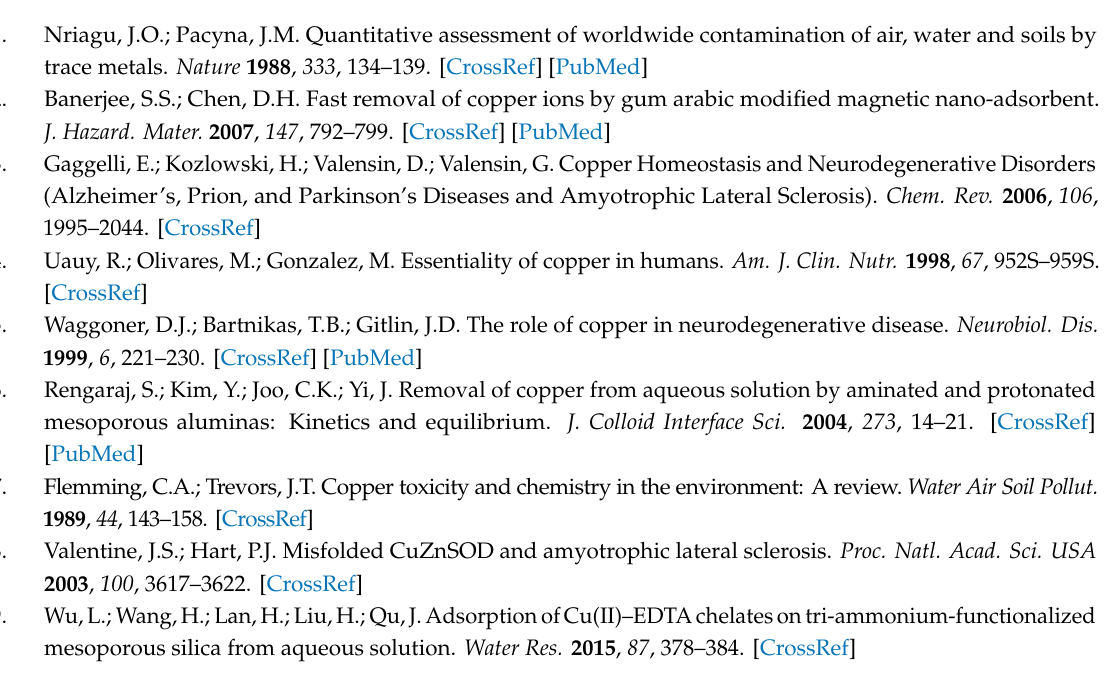
Figure S1. XRD pattern of the cobalt ferrite MNPs@ODA. Figure S2. FT-IR spectra of the pure surfactants. Figure S3. Ninhydrin colorimetric analysis of the primary MNPs@ODA with the three surface modified samples. Figure S4. UV–Vis titration of blank solution (Cu(NO 3 ) 2 ) with MNPs@ODA@PEI@DTPA. Figure S5. FT-IR spectra of the MNPs@ODA@PEI@DTPA and MNPs@ODA@DTPA before and after the adsorption of copper ions. Figure S6. FT-IR spectra of the regenerated MNPs@ODA@PEI. Figure S7. FT-IR spectra of the ligand DTPA and the copper complex. Figure S8. Proposed structure of the copper complex. Figure S9. SEM imaging and elemental analysis of the MNPs@ODA@PEI@(Cu x (DTPA) y ). Table S1. Corrected magnetization values according to the percentage of the organic